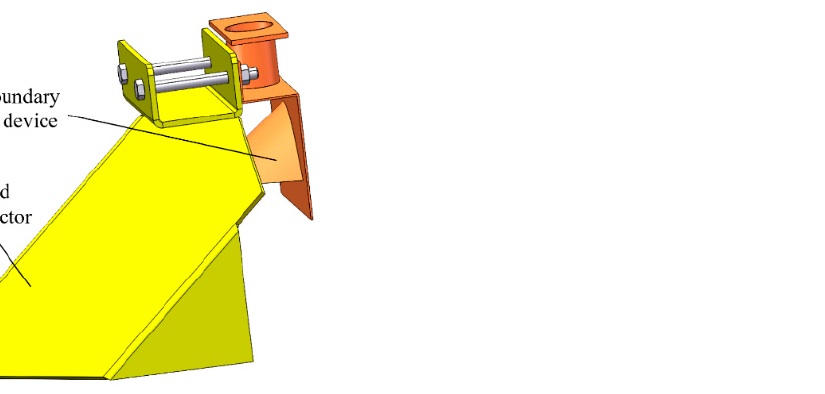
Figure 5. Assembly drawing of crushed straw deflector and wide-boundary fertilization device.